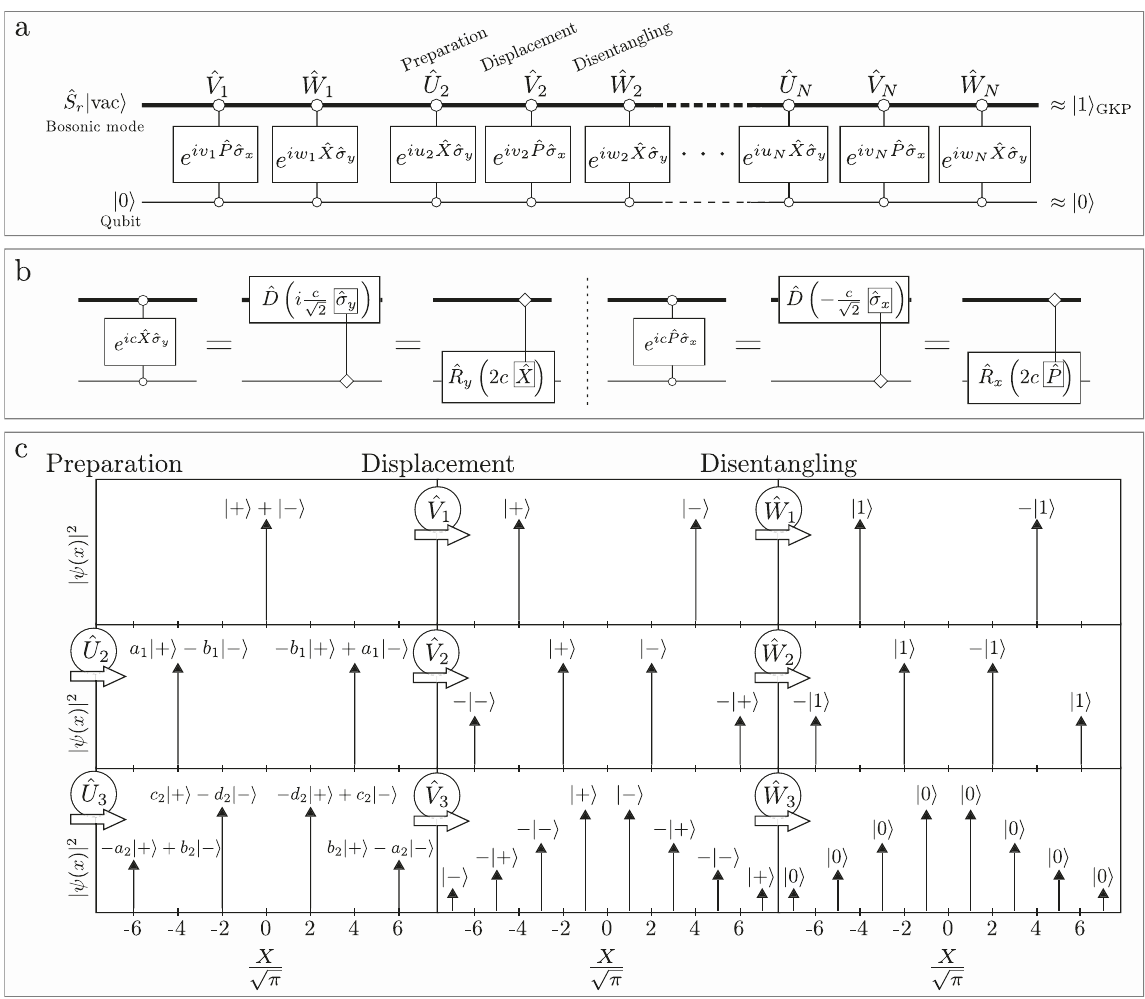
Fig. 1 Overview of the grid state-preparation protocol. a Circuit diagram of the measurement-free grid state generation protocol. The bosonic mode interacts with the qubit through a sequence of Rabi gates with interaction Hamiltonians of the form ^ P ^ σ x and ^ X ^ σ y to produce an approximate GKP 1 logic state without measurements. b The Rabi gates can be viewed either as conditional displacements on the bosonic mode depending on the qubit state or conditional rotations of the qubit depending on the bosonic state. c Illustration of the protocol for N = 3 for an in fi nitely squeezed input state. The ket above each peak in the wave function represents the state of the qubit entangled with the given peak. The displacement gates ^ V split each peak in two, creating an entangled state. The disentangling gates ^ W then rotate the qubit depending on the boson state to remove the entanglement. The preparation gates ^ U rotate the qubit before the displacement gates to control the envelope of the resulting